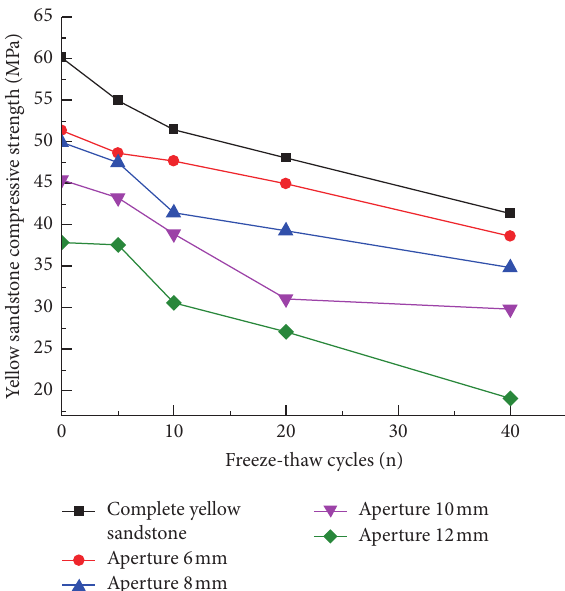
Figure 4: Compressive strength curve of yellow sandstone under freeze-thaw cycles.